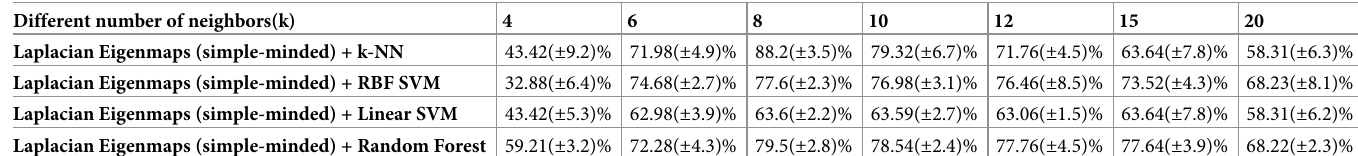
Table 3. Performance of Laplacian Eigenmaps (simple-minded) and different classifiers vs. different number of neighbors (k) on the EMG signals (F1 score ± SE). Different number of neighbors(k)